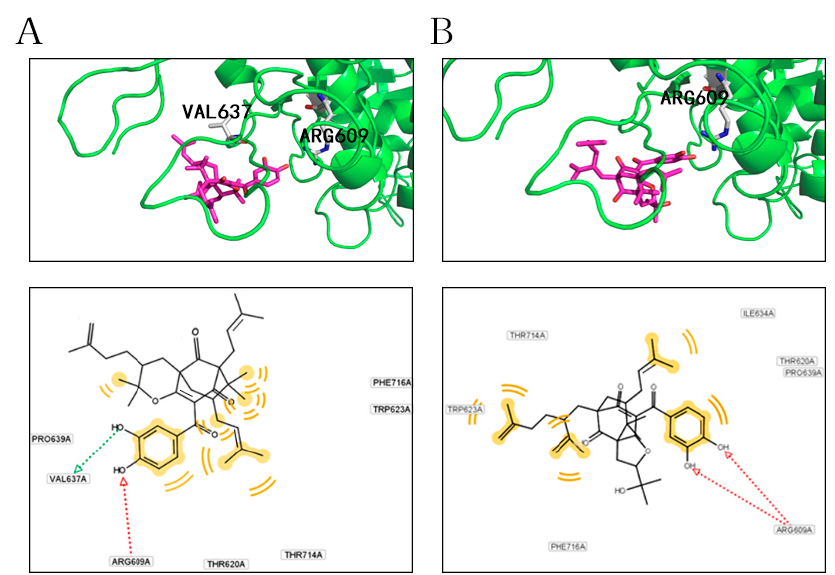
Figure 5. Virtual molecular docking pattern of compounds 2 ( A ) and 5 ( B ) with the SH2 domain of STAT3 crystal (1BG1). Green cartoon refers to protein structure, blue sticks refer to compound molecules, and yellow dashed lines refer to hydrogen bonds, with the number on the dashed line representing distance (Å).